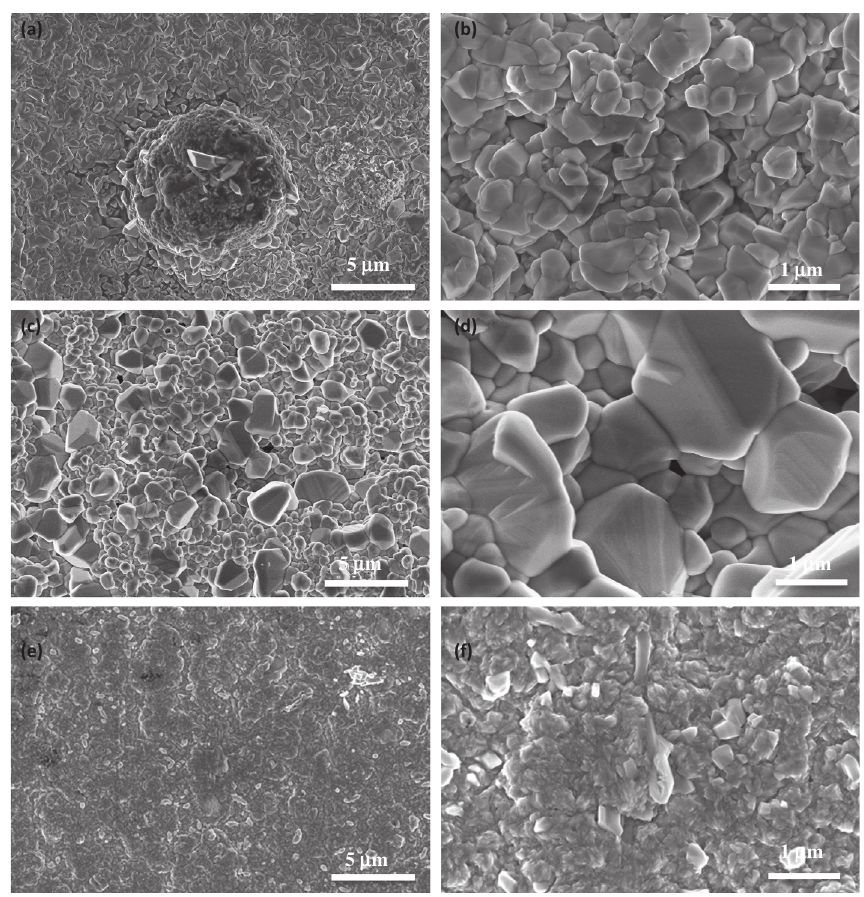
Figure 3: Surface morphologies of Inconel 740H after oxidation: (a, b) 750°C, in static air, (c, d) 850°C, in static air and (e, f) 750°C, in pure